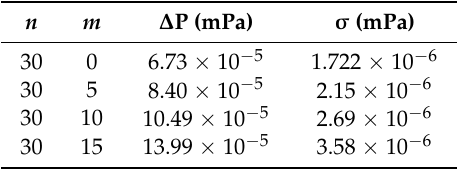
Table 1. Calculated pressure drops ( ∆ P ) and shear stresses ( σ ) for different m.